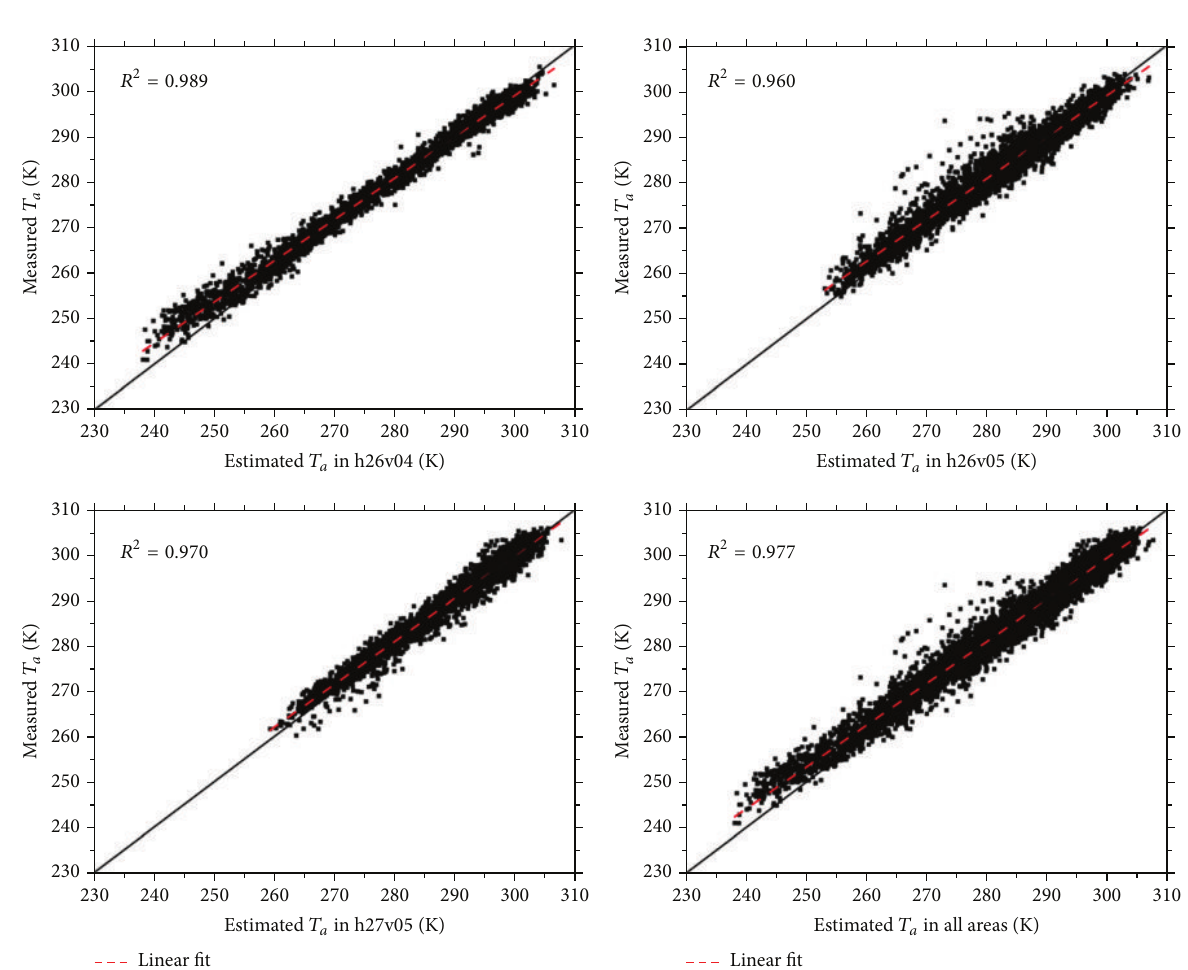
Figure 2: Comparisons between the estimated and measured 𝑇 𝑎 values in three case study areas covered by the MODIS tiles h26v04, h26v05, and h27v05. (The figure is cited from Sun et al.